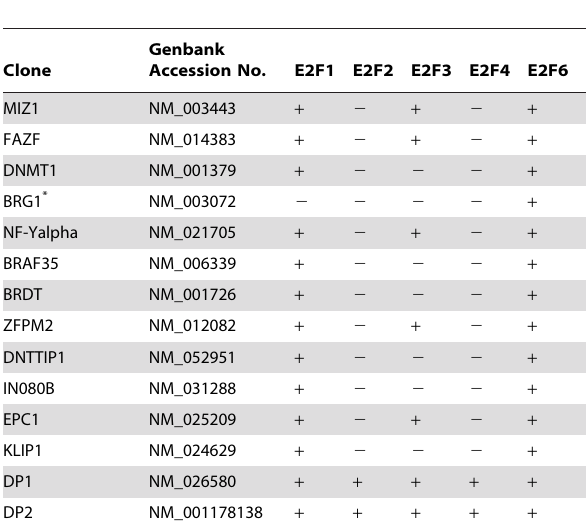
Table 1. E2F6-interacting proteins identified from a yeast two-hybrid